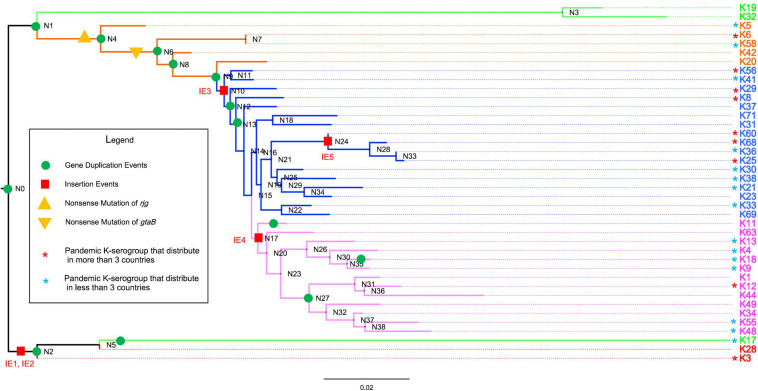
The evolution of 40 K-serogroup CPSgcs. Five groups of 40 K-serogroups are indicated by different colors for the branch and tips: group 1 in red, group 2 in green, group 3 in orange, group 4 in blue, and group 5 in purple. Node IDs were displayed, and the red square and green circle on certain branches refer to insertion events and duplication events, respectively. For gene duplication events, the concrete information is listed in Table 4. For insertion events, the sequence of IE1 (insertion event 1) contains wecA, cysN, OG095, cysC, cysD, OG098, xcpT, xpsE, epsF, OG102, OG103, OG104, gspK, OG106, OG107, OG108, xpsD, bdbD, and wecA (19 genes in total); IE2 contains Rv2957, OG114, OG115, OG116, OG117, wbbL, OG118, OG119, and Rv2957 (9 genes); IE3 contains gnu, espL, and pglF (3 genes); IE4 contains gmd, fcl, gmm, mand, glmM, and manA (6 genes); IE5 contains OG048, OG049, OG050, OG051, OG052, OG053, and OG054 (7 genes). Pandemic K-serogroups are indicated by star (*) according to a previous study (Han et al., 2016). Nonsense mutations of rjg and gtaB are indicated as yellow triangle and inverted triangle.